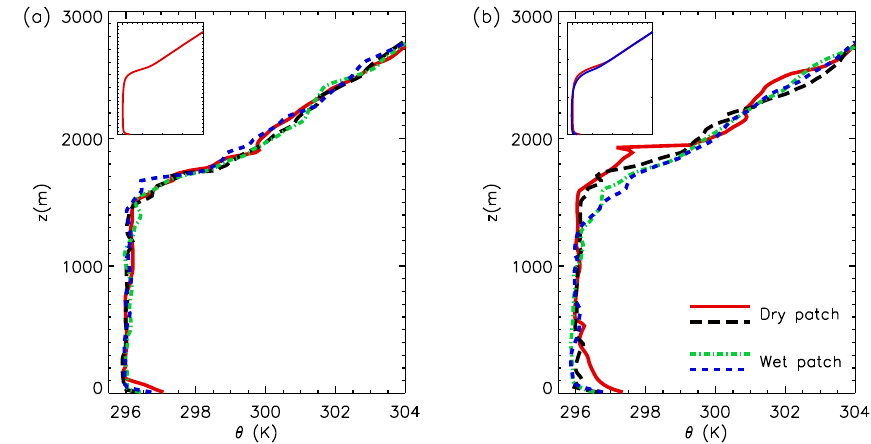
Fig. 13. Instantaneous and local potential temperature profiles as generated by DALES after 3 h of simulation. Panel (a) shows 4 profiles at different locations, while its inset shows the instantaneous horizontal average over the total domain. In panel (b) , 2 instantaneous profiles are displayed for the dry patch and 2 profiles for the wet patch. Its inset presents the horizontal averages over the dry and wet patch separately.